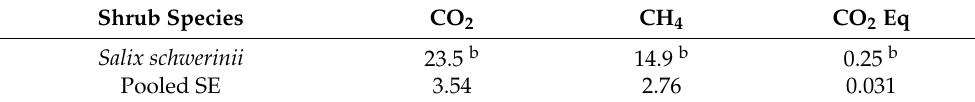
Table 10. Cont. Shrub